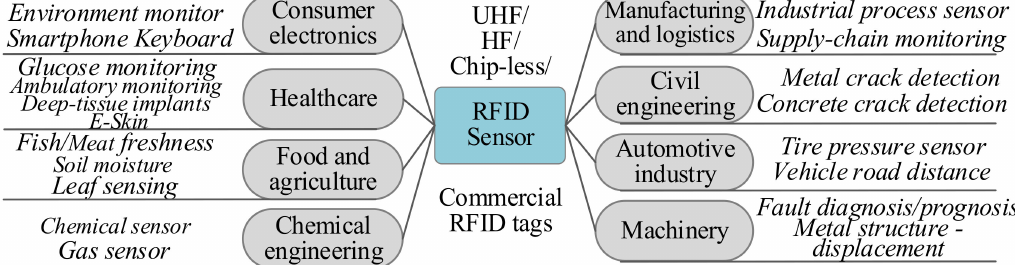
Figure 11. Application Fields and Examples of RFID Sensor